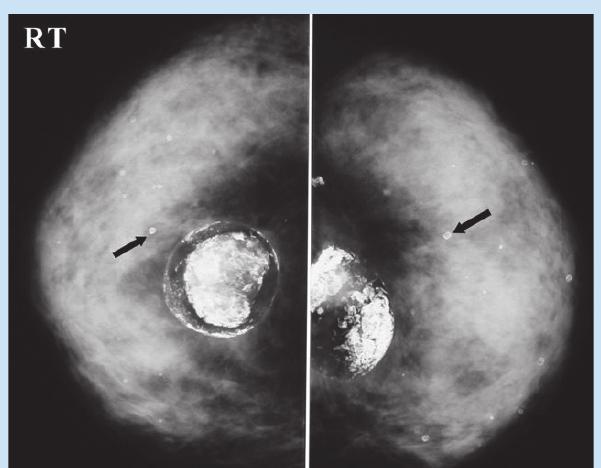
Fig. 5. Symmetrical mass in each breast with calcified centre and calcified rim. Multiple small round calcifications with translucent centre, typical of oil cysts (arrows).